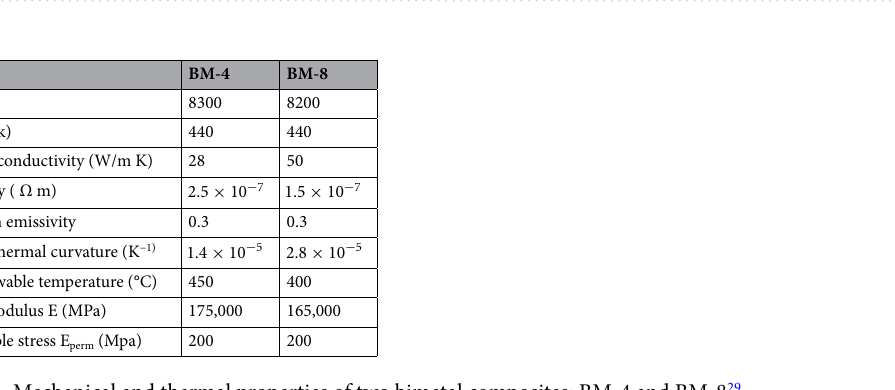
Table 5. Mechanical and thermal properties of two bimetal composites: BM-4 and BM-8 29